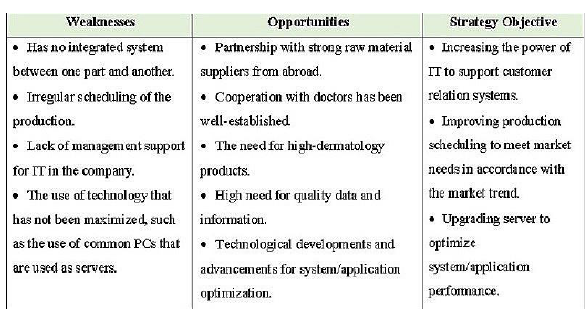
Figure 9: Information System Solution from SWOT